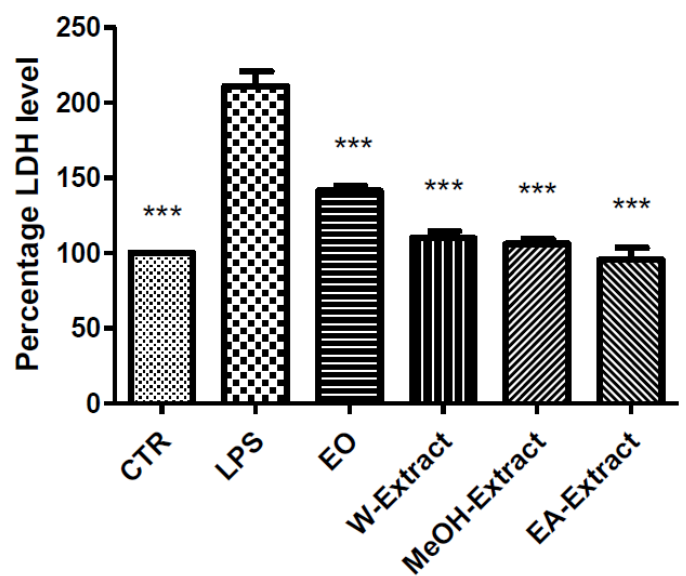
Figure 1. Effect of essential oil (EO) and water (W), methanol (MeOH) and ethyl acetate (EA) A. santonicum extracts (100 µg/mL) on lipopolysaccharide (LPS)-induced lactate dehydrogenase (LDH) level in rat colon specimens. All extracts were able to restore the level of LDH observed in control (CTR) group. p < 0.001; post-hoc, *** p < 0.001 vs. LPS.